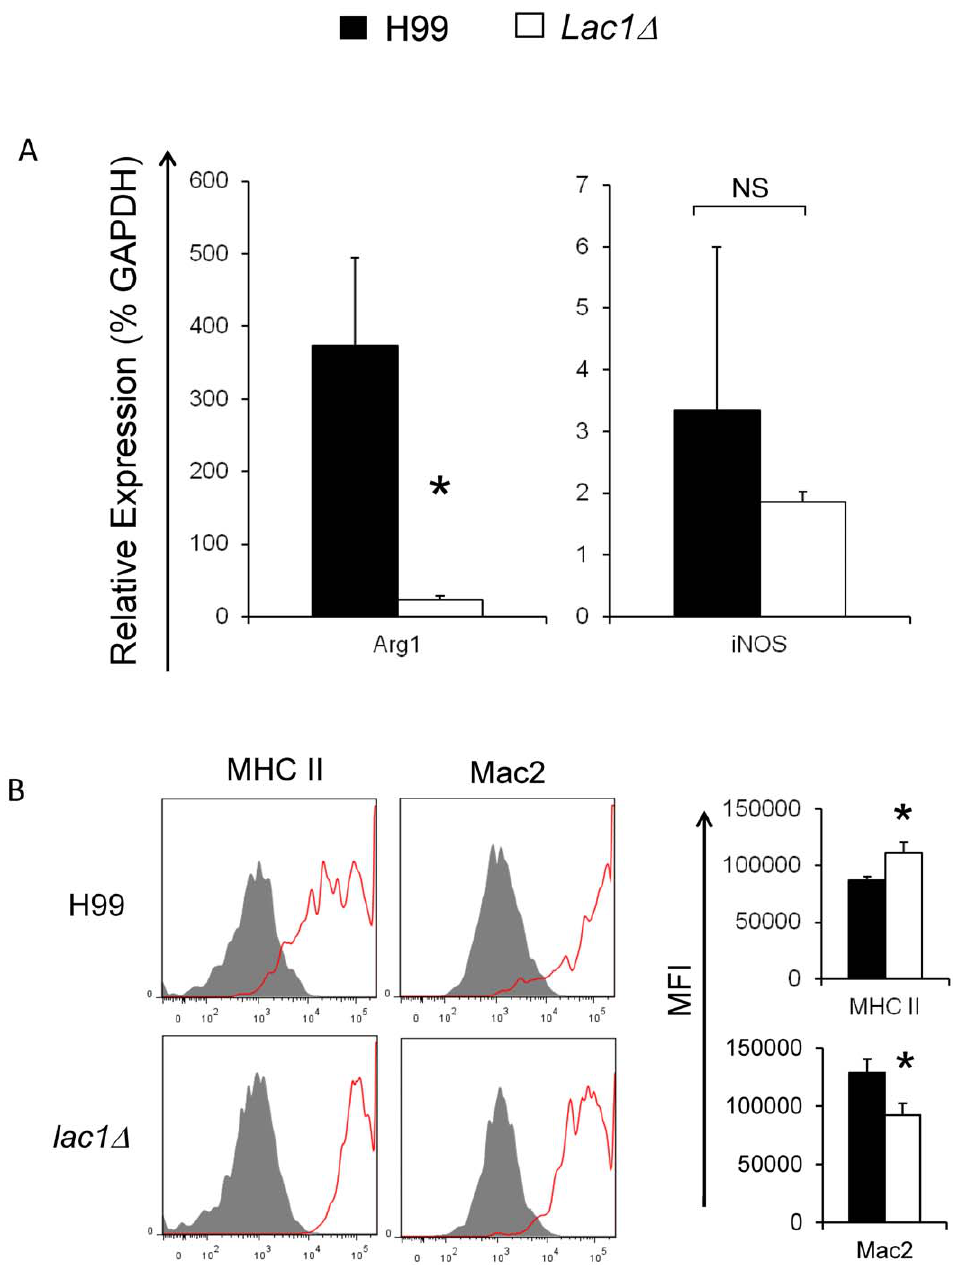
Figure 3. Effect of cryptococcal laccase on the activation of pulmonary macrophages. Lung leukocytes were isolated from uninfected mice or mice infected with C. neoformans strain H99 or lac1 D at 3 wpi. (A) Pulmonary macrophages were purified as described in methods. RNA was extracted, converted to cDNA, and evaluated by qPCR to quantify alternative (Arg1) versus classical (iNOS) macrophage activation gene expression. The data were normalized to GAPDH mRNA levels and expressed as percentage of GAPDH (% GAPDH). (B) Pulmonary macrophages (CD11c + /F4/80 + ) were gated from CD45 + lung leukocytes by flow cytometry analysis. The activation phenotype of pulmonary macrophages was evaluated by the surface expression of MHC class II (MHC II) and Mac2. Specific antibody staining is depicted as solid lines and isotype-control staining as shaded histograms. The bar graph presents mean fluorescence intensity (MFI) of positive cells derived from these histograms. Note that H99 infection was associated with increased expression of Arg1, compared with macrophages obtained from lac1 D -infected mice. In contrast, H99 infection was associated with increased expression of Mac2 and decreased expression of MHC II in the pulmonary macrophages, compared with lac1 D -infected mice. Bars represent data (mean 6 SEM) from 2–3 separate matched experiments, N =6 and above for each of the analyzed parameters; *p , 0.05 in comparison between wt and mutant; NS, no significant difference between wt and mutant.